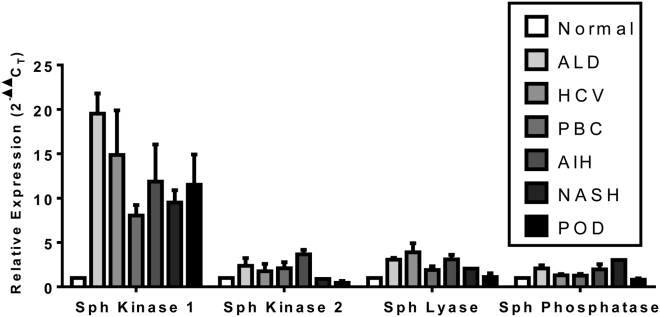
Hepatic gene expression across differing etiologies of liver disease. Samples of frozen liver tissue were obtained from either normal donor liver or explanted livers from patients with liver disease. Gene expression of sphingosine kinase 1, sphingosine kinase 2, sphingosine lyase, and sphingosine phosphatase relative to glyceraldehyde-3-phosphate dehydrogenase was determined. Bars represent means ± SEM fold change relative to normal liver (no statistical comparison, n = 3 per group). AIH, autoimmune hepatitis; ALD, alcoholic liver disease; HCV, hepatitis C virus; NAFLD, nonalcoholic fatty liver disease; PBC, primary biliary cirrhosis; POD, paracetamol overdose.